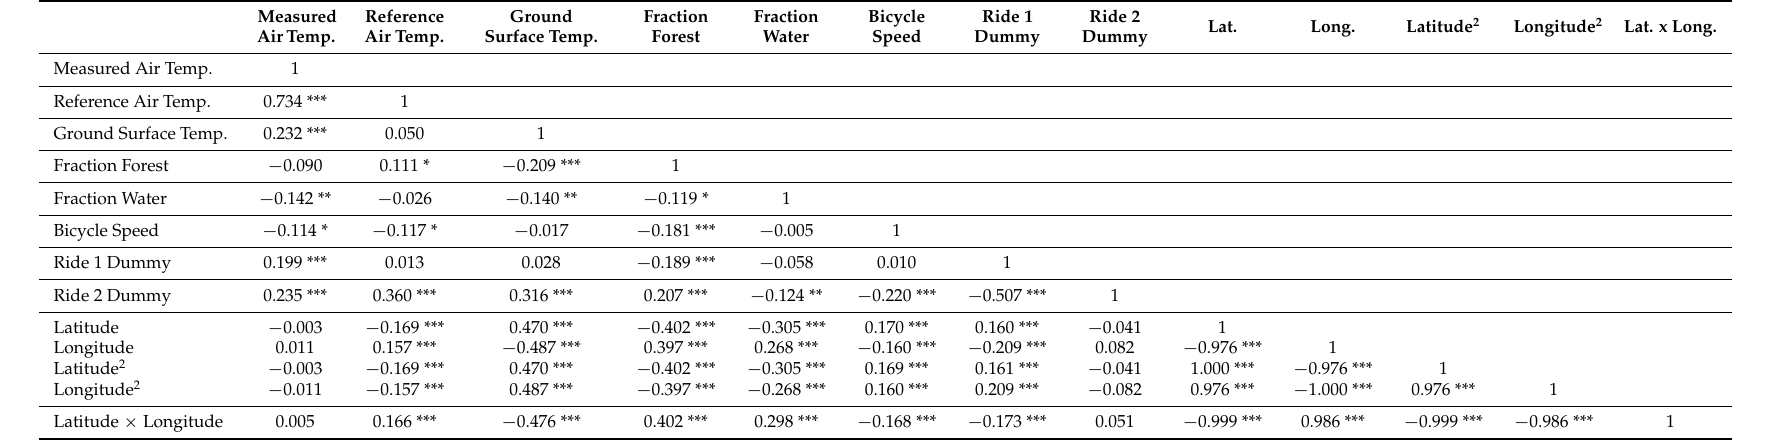
Table 4. Bivariate correlations among physical characteristics and measured air